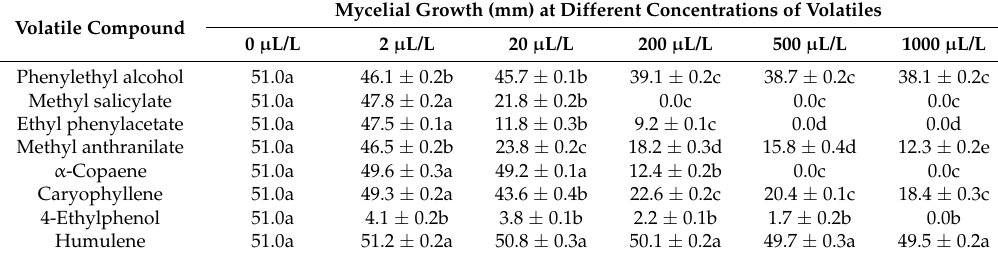
Table 5. Effect of volatile compounds on P. litchii mycelial growth.